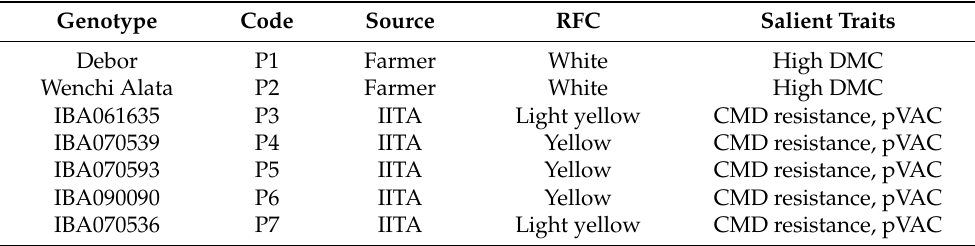
Table 1. List of progenitors used in the